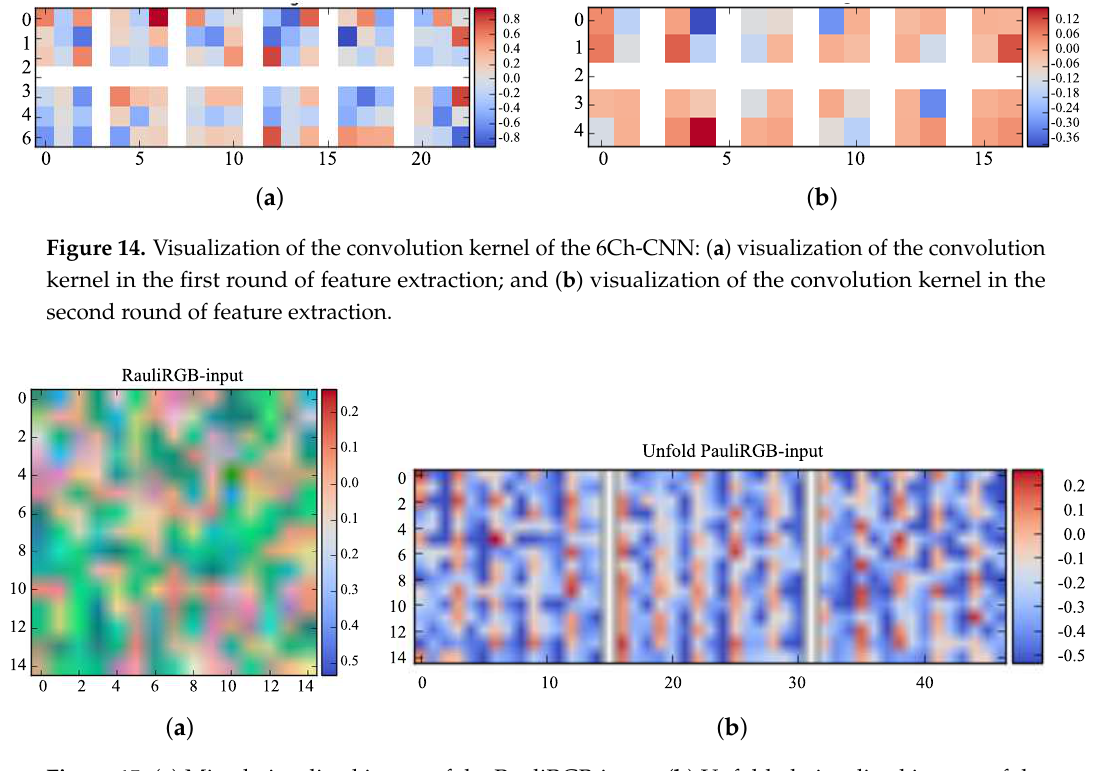
Figure 15. ( a ) Mixed visualized image of the PauliRGB-input; ( b ) Unfolded visualized images of the PauliRGB-input.